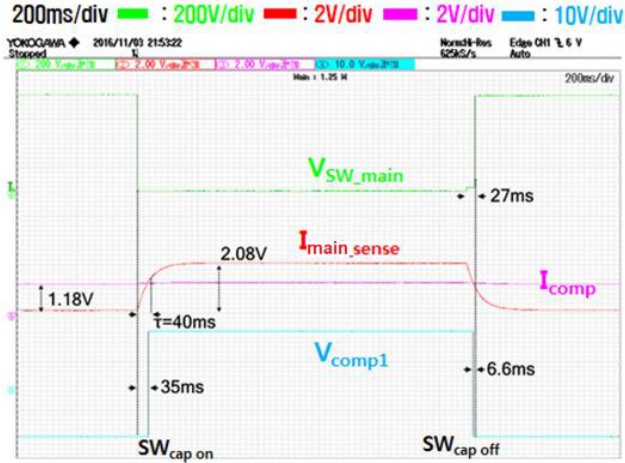
Figure 6. Output of Comparator 1 (V comp1 ) to turn on/off the capacitor branch circuit.